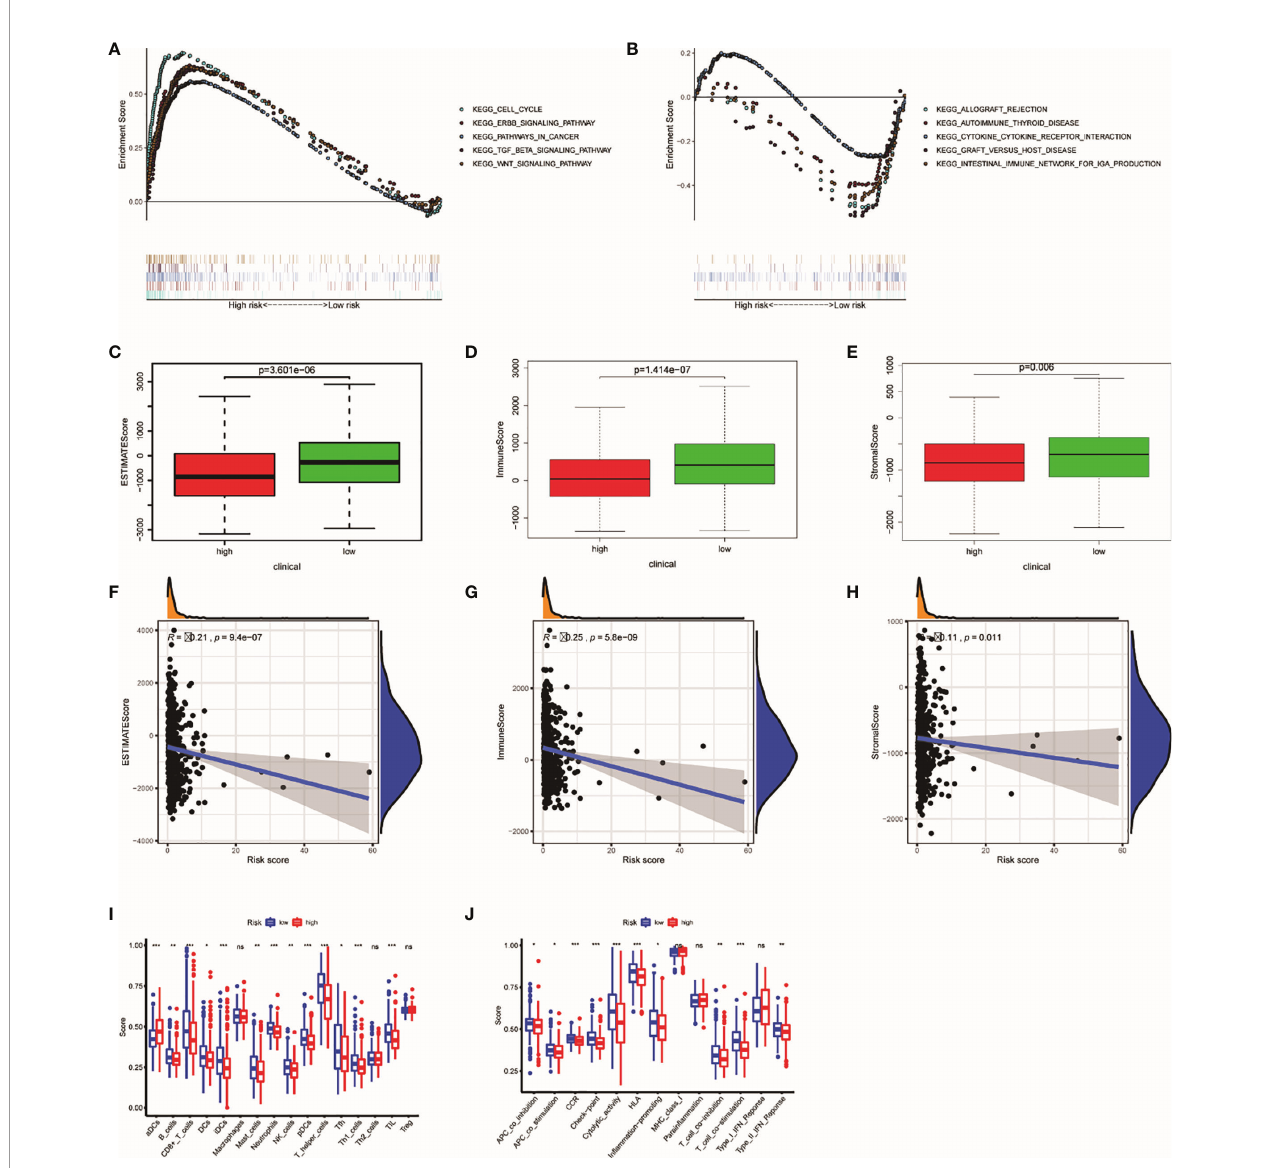
FIGURE 7 | The results of GSEA and ESTIMATE and ssGSEA analysis. Gene set enrichment analysis based on KEGG of high- and low-risk groups (A, B) . The boxplot showed the difference in ESTIMATE score (C) , immune score (D) , and stromal score (E) calculated using ESTIMATE algorithm between the two groups. The plot showed the relationships between ESTIMATE score (F) , immune score (G) , and stromal score (H) . The difference in each immune cell (I) and immune function (J) calculated by ssGSEA method between high- and low-risk groups. *P < 0.05; **P < 0.01; ***P < 0.001. ns, not signi fi